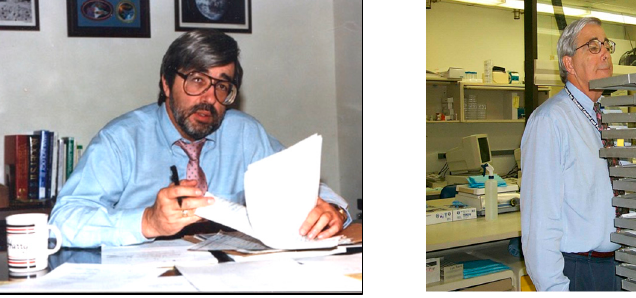
Figure 4. Various pictures over Dr. Hannon’s career. Picture on left shows Dr. Hannon in 1988, with more recent pictures center and right. (All photos donated by Hannon family friend for this publi- cation.).